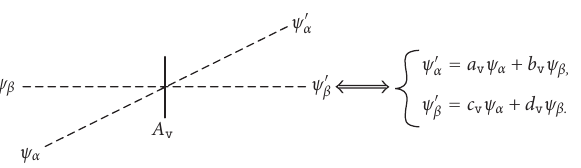
Figure 2.1. Vertex v is formed by intersection of α - and β -lines of auxiliary lattice. Vertex linear prob- lem is the pair of relations binding four edge